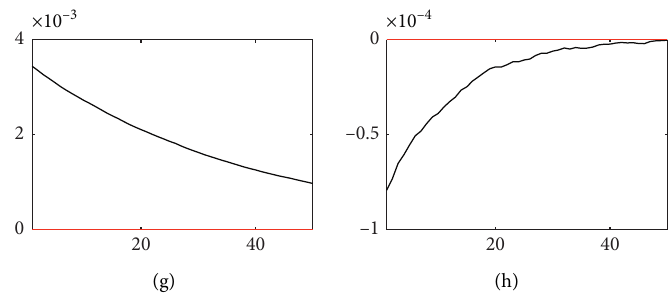
Figure 4: Impulse response to a government expense shock. (a) C . (b) W . (c) N . (d) K . (e) Y . (f) Z . (g) G . (h) I